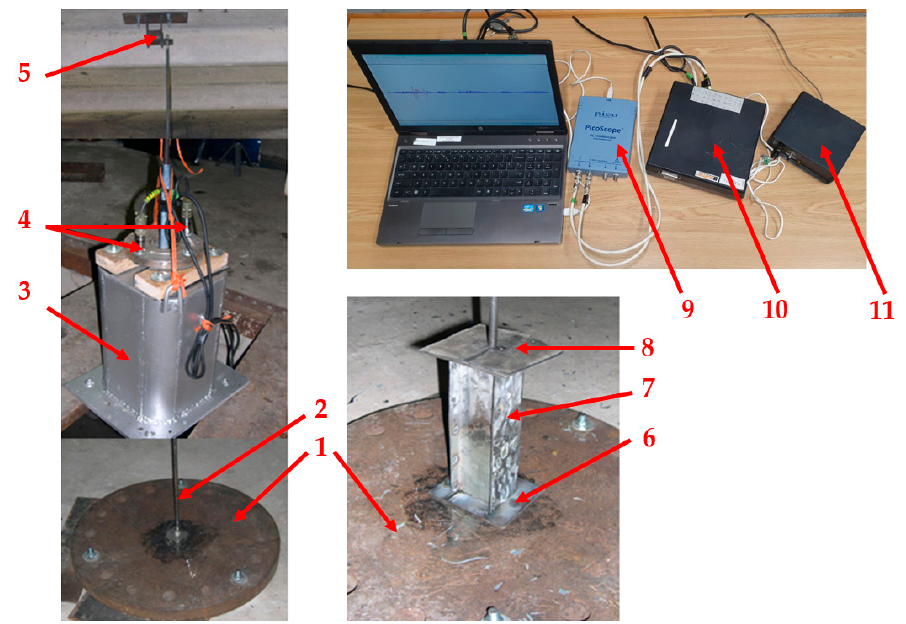
Figure A1. General view of the test bench for dynamic buckling experiments; (1—test bench base; 2—guiding rod; 3—impactor body; 4—Wilcoxon 784A accelerometer sensors; 5—upper attachment point of the guiding rod; 6—alignment plate; 7—specimen; 8—rubber gasket; 9—PicoScope signal converter—3424; 10—sensors power supply device; 11—power supply device).